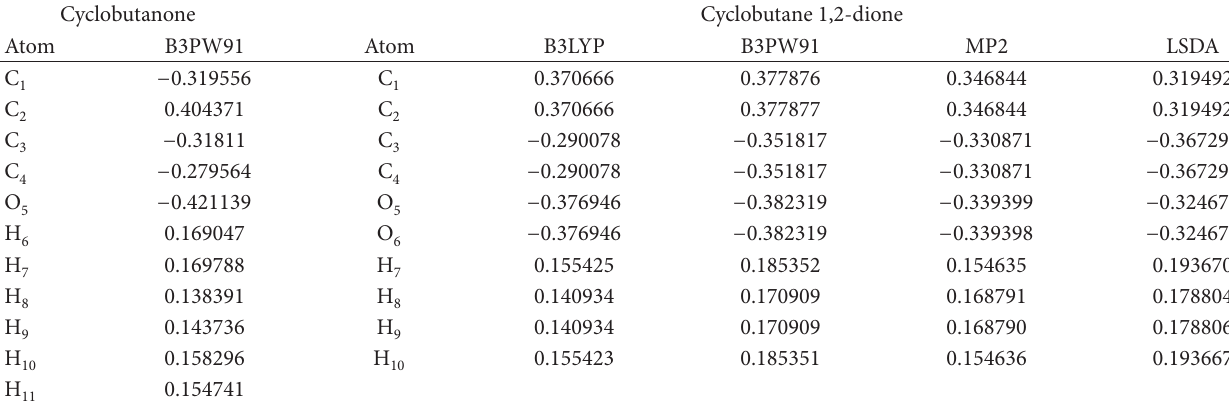
T 4: Atomic charges (e) of the title compounds in gas phase.